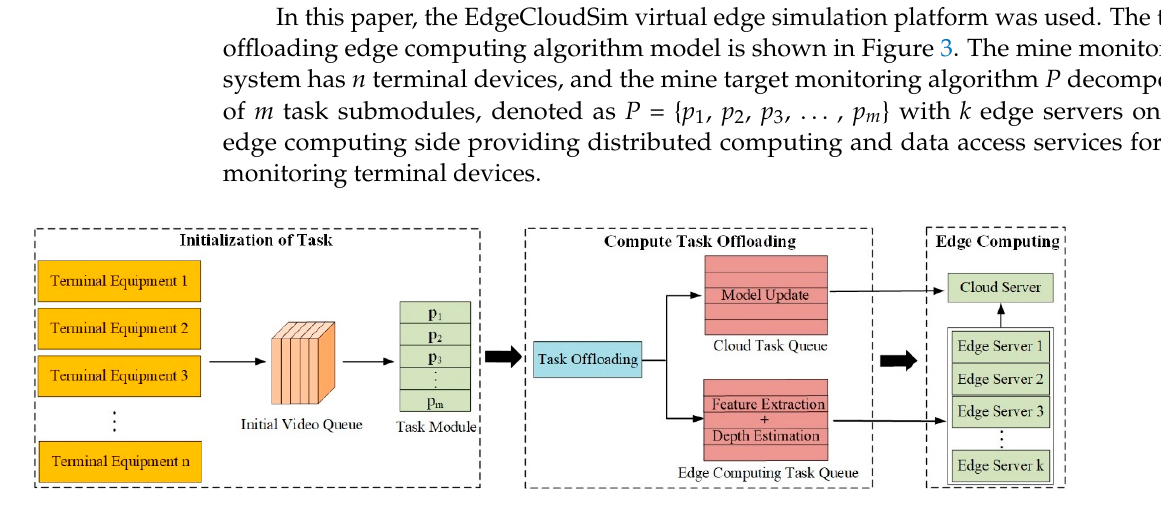
Figure 3. The task-offloading edge computing algorithm model.